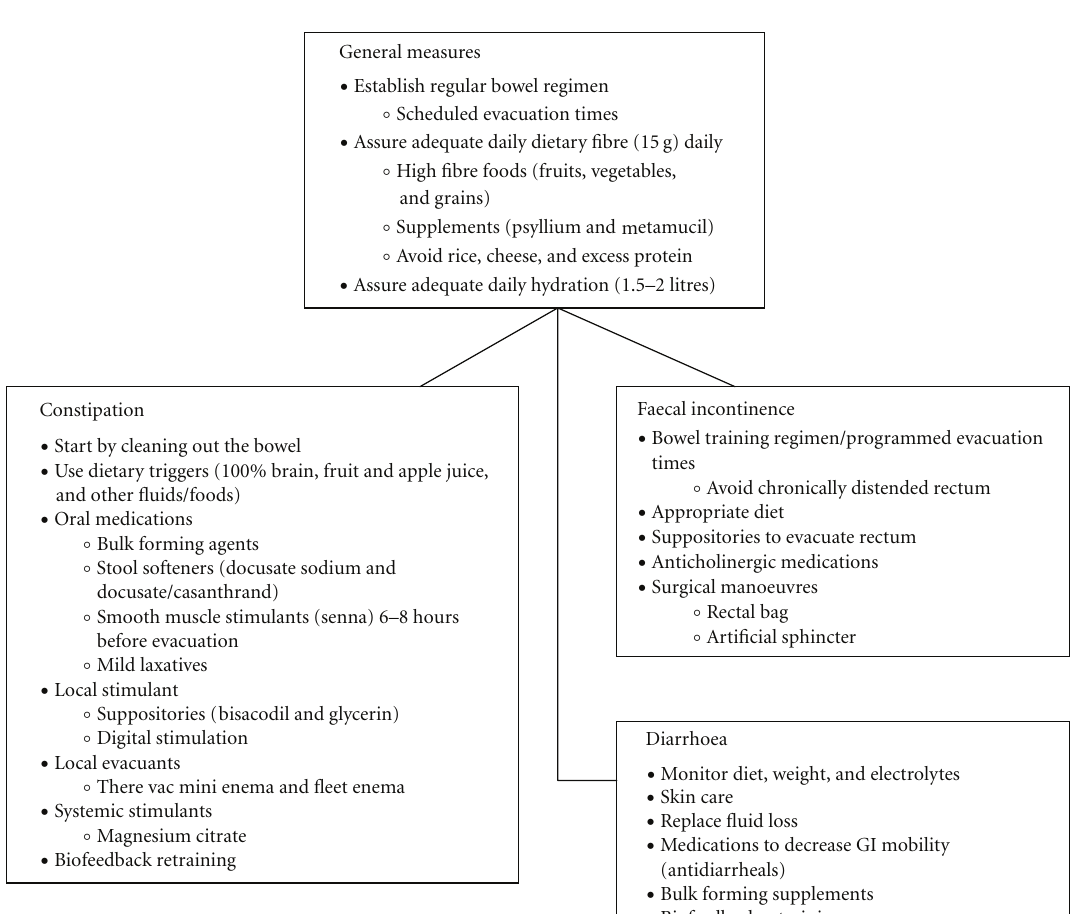
Figure 5: Management of bowel problems in MS. (Adapted from: Miller et al.